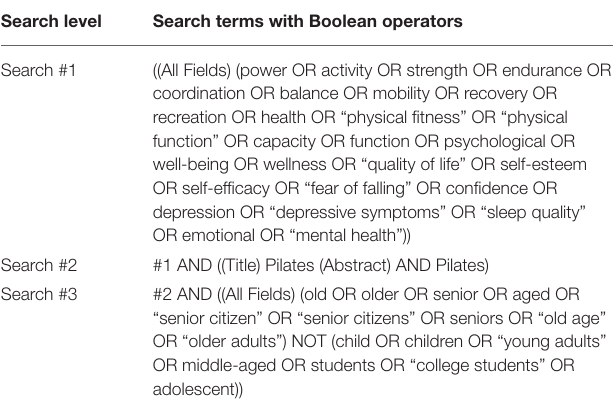
TABLE 1 | Search levels and search terms of the literature search